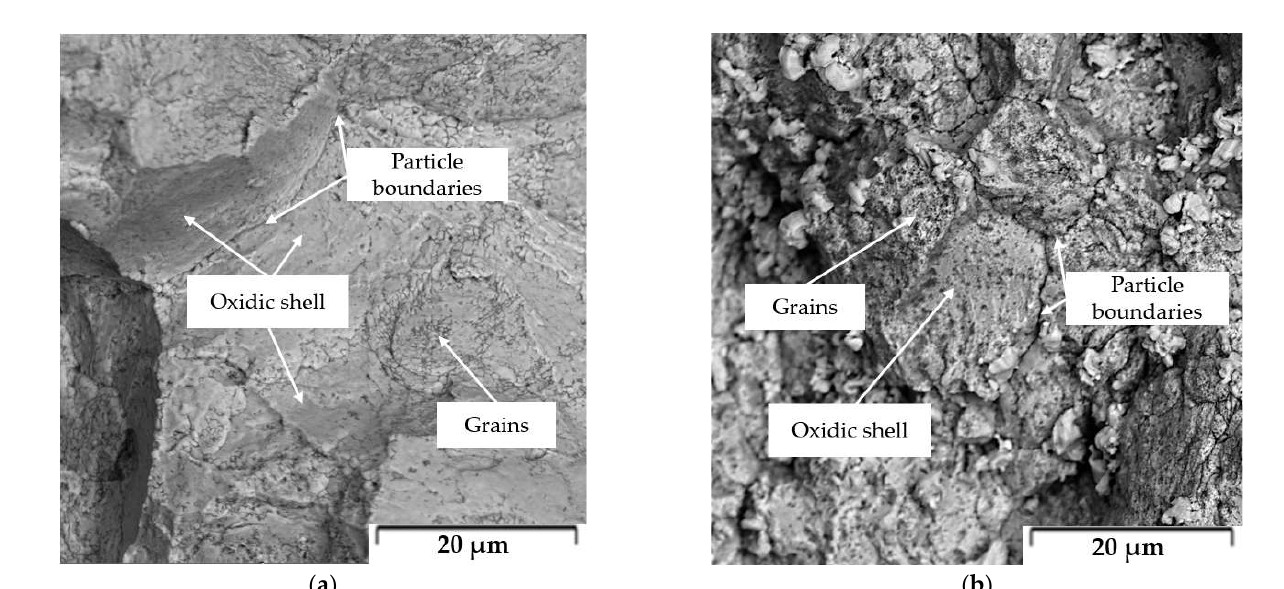
Figure 10. Fractography of samples after 3-point bend test: ( a ) Zn-1Mg, ( b ) Zn-6Mg . Table 4. Mechanical properties of materials compacted by the SPS.